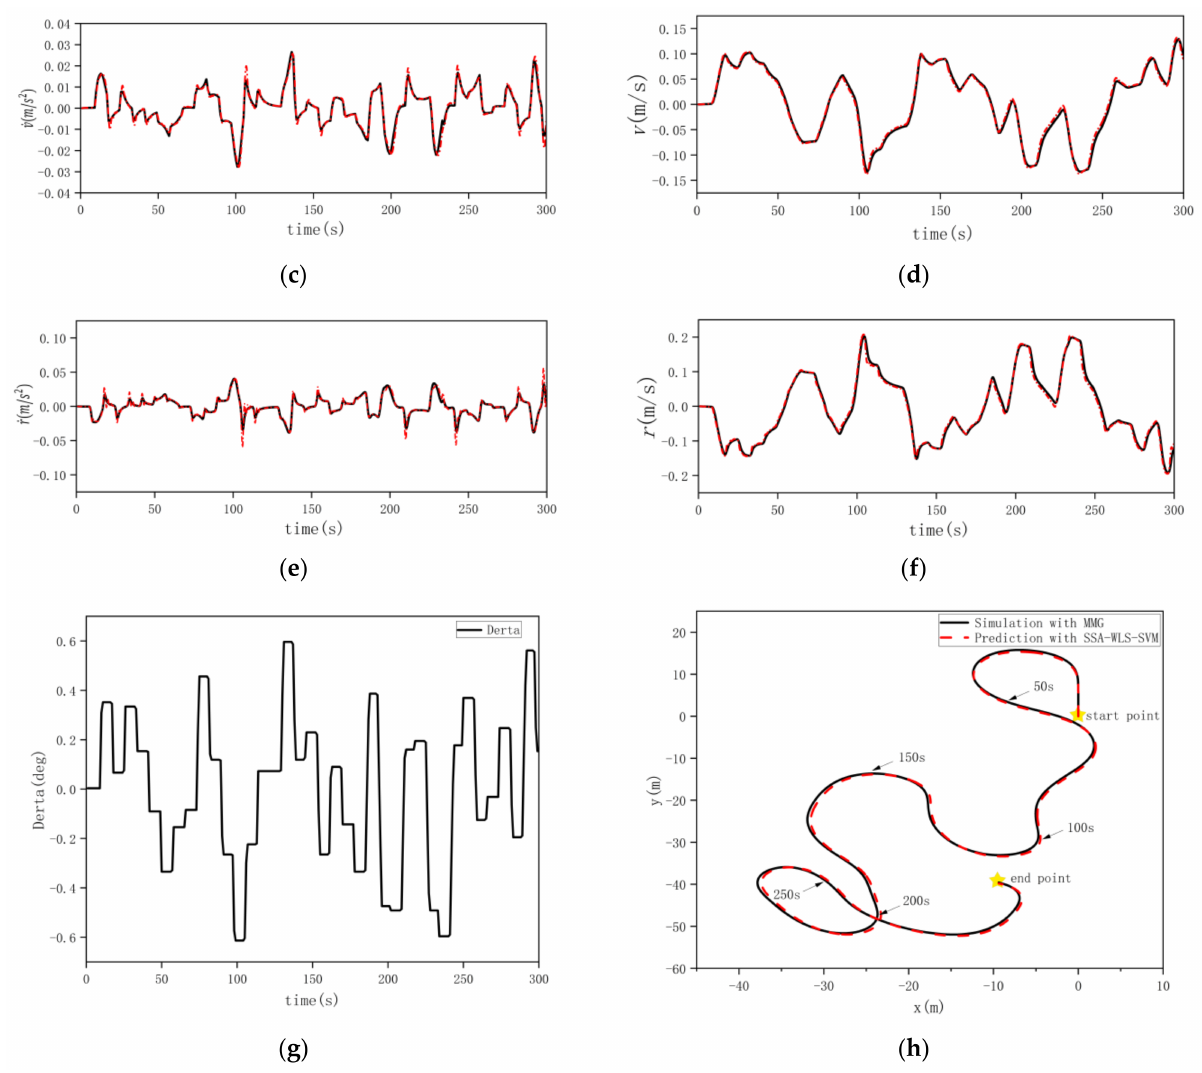
Figure 13. Comparison of the prediction with SSA-WLS-SVM and simulation in dataset 2. ( a ) Longitu- dinal acceleration. ( b ) Longitudinal velocity. ( c ) Lateral acceleration. ( d ) Lateral velocity. ( e ) Steering angular acceleration. ( f ) Steering angular speed. ( g ) Rudder angle. ( h ) Track of USV.